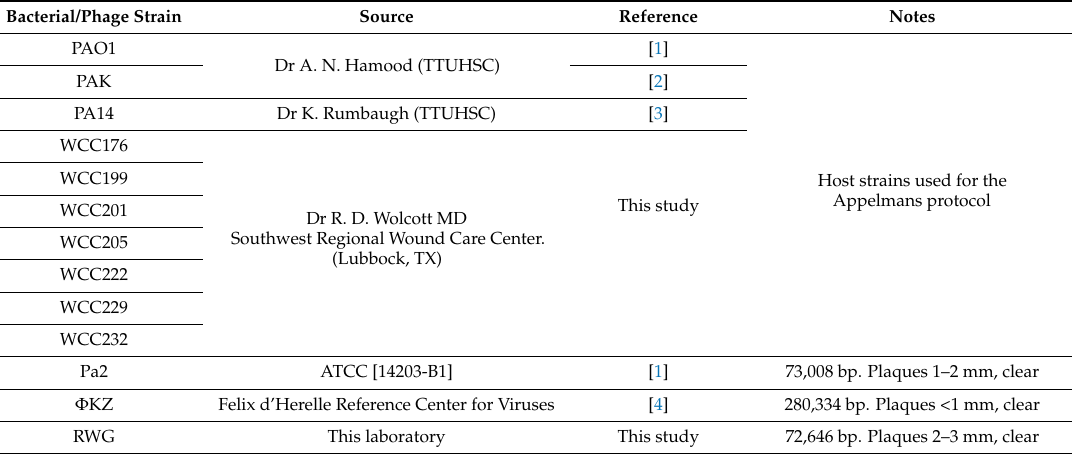
Table 1. Pseudomonas aeruginosa and bacteriophage strains used for the Appelmans protocol. Plaque morphologies are described for growth on